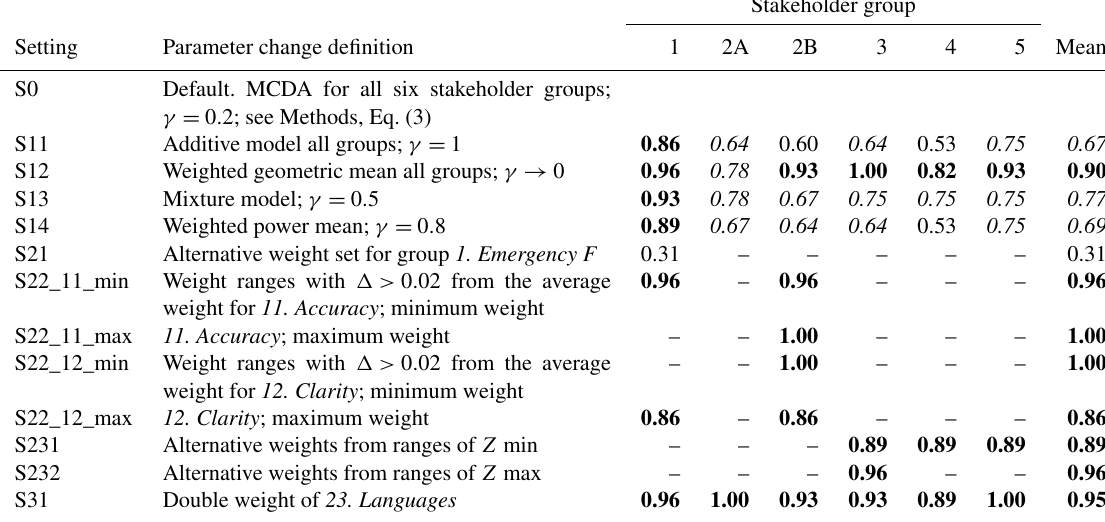
Table 3. Results of sensitivity analyses. Setting S0: default with elicited preferences of stakeholder groups and the weighted power mean model – Eq. (3). Settings S11–S14: effect of other aggregation models (varying γ ). S21–S22: uncertainty of Swing weights. S231–S232: uncertainty of Simos’ card weights. S31: increased (possibly underestimated) weight. S11–S31: all other parameters as S0. Column groups 1–5: Kendall’s τ rank correlation coefficient between ranks of FEWS in the main MCDA (setting S0) and ranks resulting from MCDA using other settings (S11–S31) for stakeholder groups (e.g., group 1. Emergency-F ). Column mean: correlation between S0 and the average rank over all groups for which analysis was done. Note: S21 was only done for group 1. Emergency-F (i.e., mean is group correlation). Kendall’s τ 1: identical ranks; 0: no correlation; − 1: inverse relationship; –: not applicable. Kendall’s τ from 0.81 to 1.00: bold, indicating very good agreement between the changed setting and S0; τ from 0.61 to 0.80: